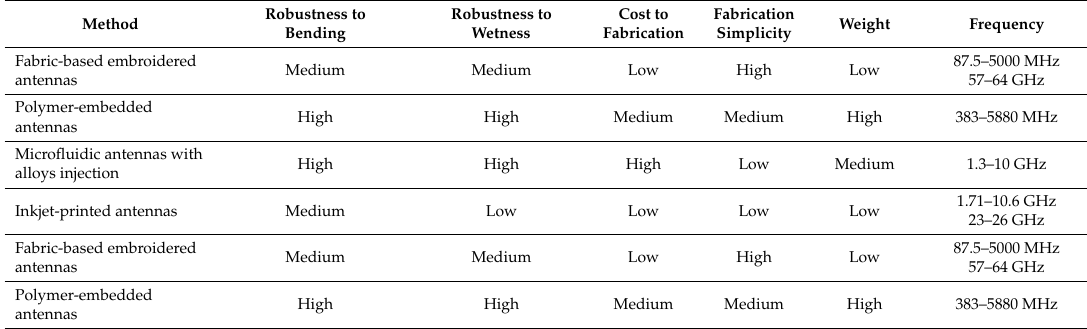
Table 6. Comparison of the properties of the presented advanced manufacturing techniques for wearable